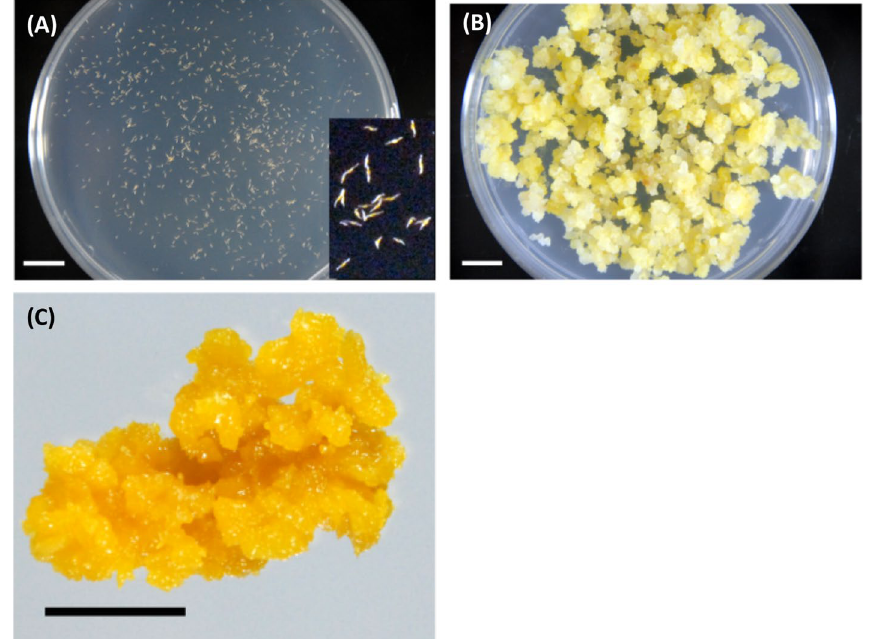
Fig. 1 Callus induction, growth, and extraction of B. formosana . A The seeds of the current year’s flowering were plated for callus induction. B Callus with stable growth and loose texture. C Appearance of the extract through SFE‑CO 2 from B. formosana callus. Scale